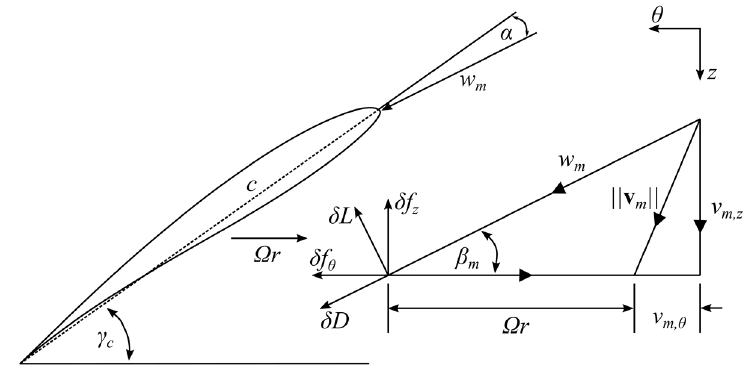
Figure 4. EADM vector diagram.